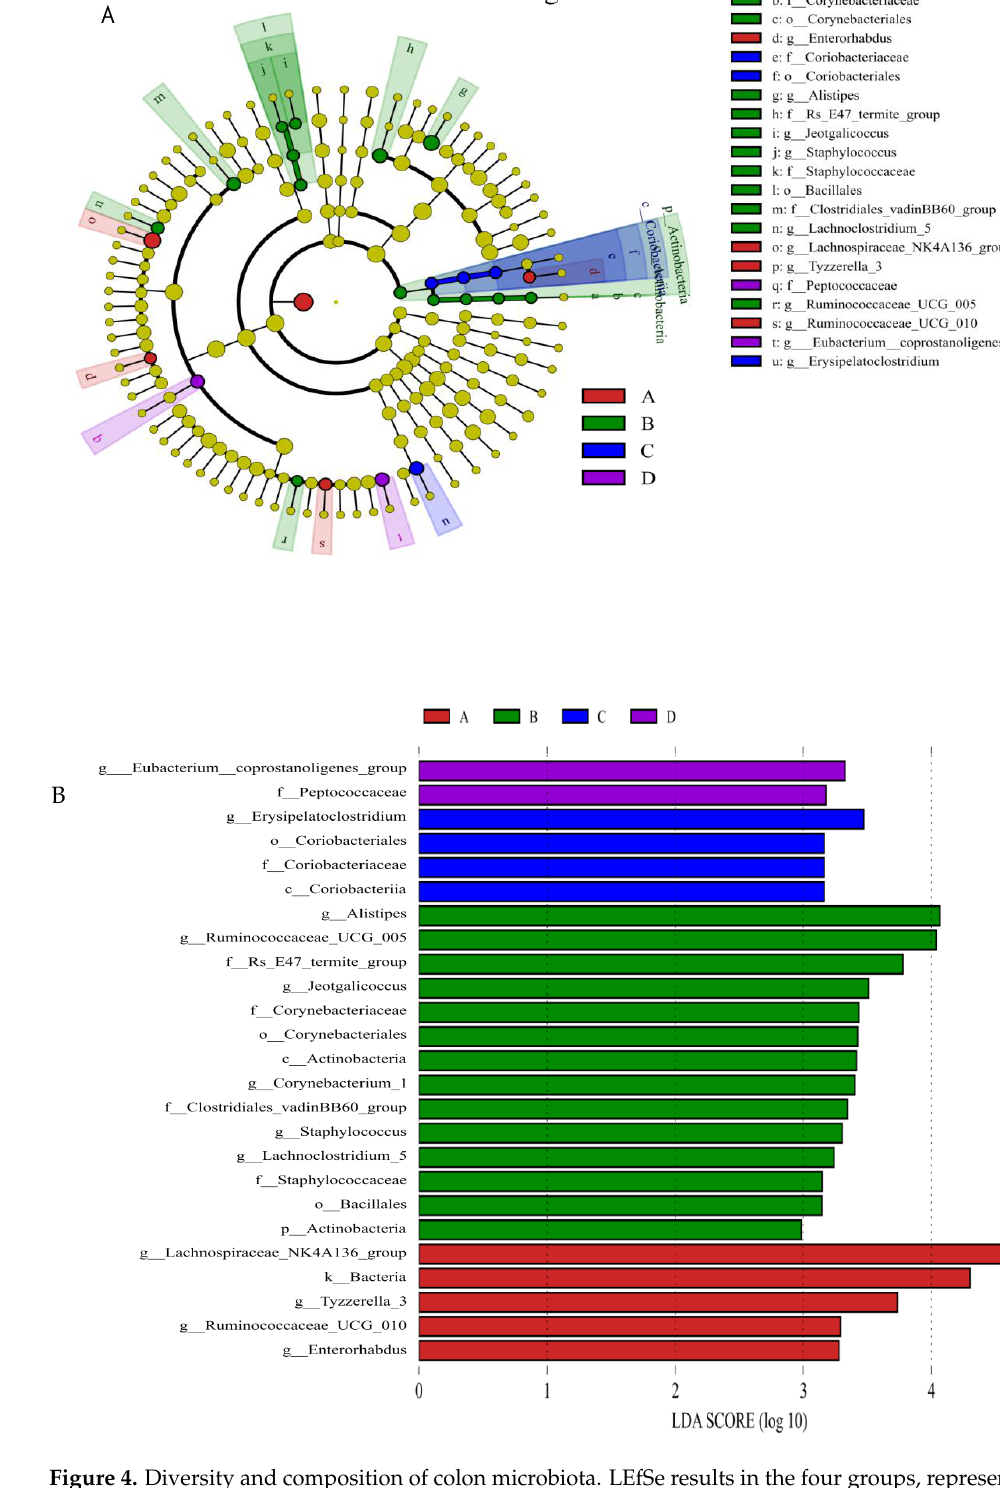
Figure 4. Diversity and composition of colon microbiota. LEfSe results in the four groups, representing the relevant features on taxonomic trees ( A ) and Key phylotypes in the colon responding to treatments were identified by the LEfSe algorithm ( B ). ( A ) Control group; ( B ) L. salivarius group; ( C ) C. butyricum group; ( D ) Combined treatment group.